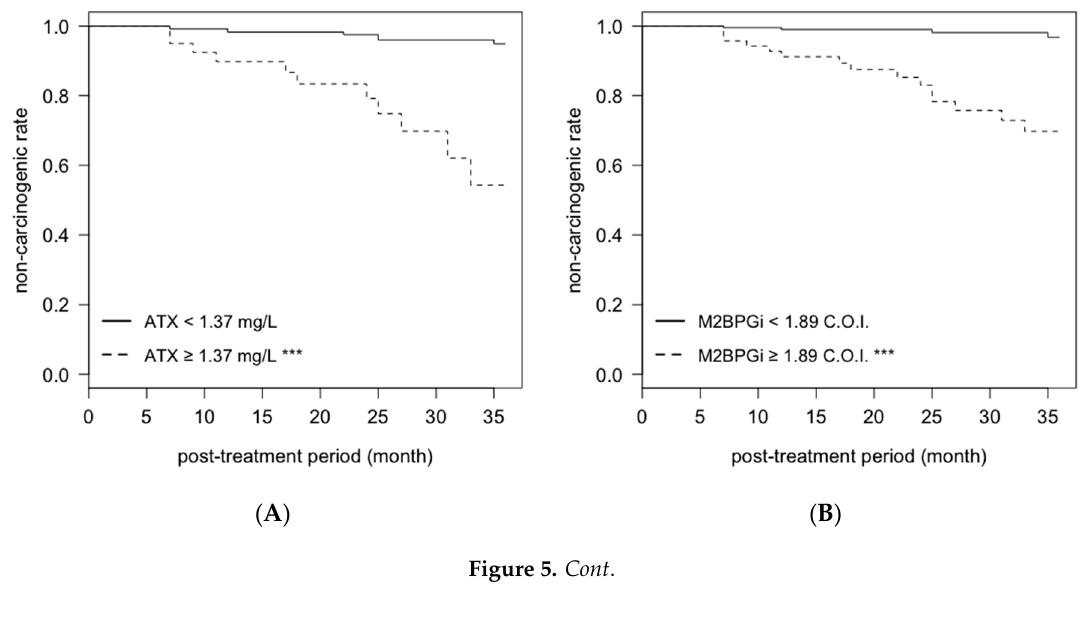
Table 1. Factors associated with post-SVR HCC development.